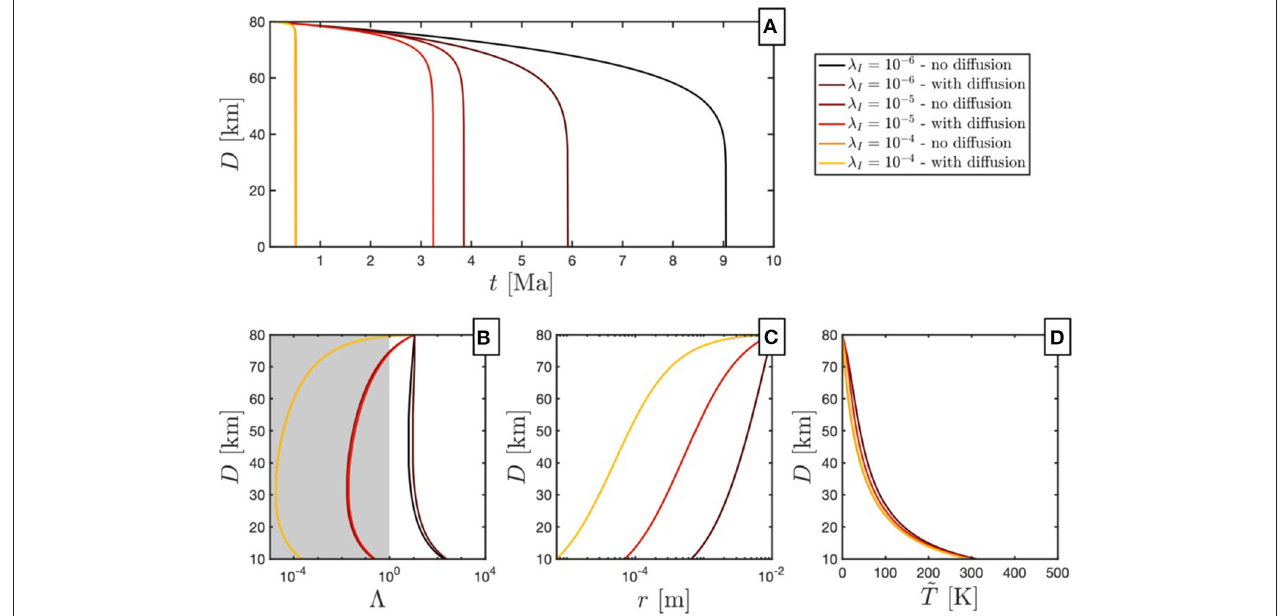
FIGURE 10 | Examples of six simulations with a slab temperature of 1,100 K, a slab thickness of 80 km and an initial interface curvature of 1 cm are shown to illustrate the impact of thermal diffusion and the interface partitioning factor λ I . (A) Evolution of neck thickness D vs. time. (B) Relationship between neck thickness D and deformation mechanism ratio 3 (with values smaller than 1 indicating diffusion creep dominated deformation. (C) Relationship between interface curvature r and D . (D) Relationship between temperature increase ˜ T and neck thickness D . Non-visible lines in the respective plots lie on top of each